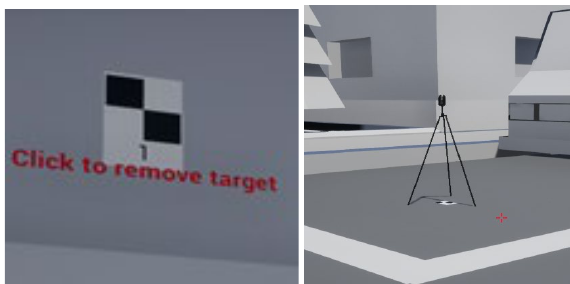
Figure 3: Target placing and laser scanner positioning in